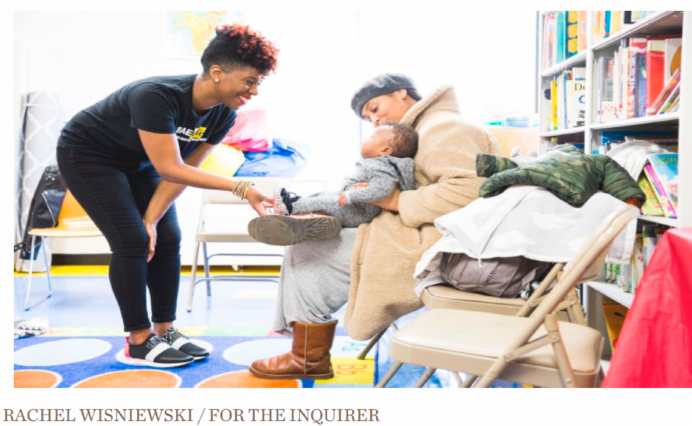
Figure 1. BAE Cafe feature from CHOP Policy Lab on decreasing disparities.